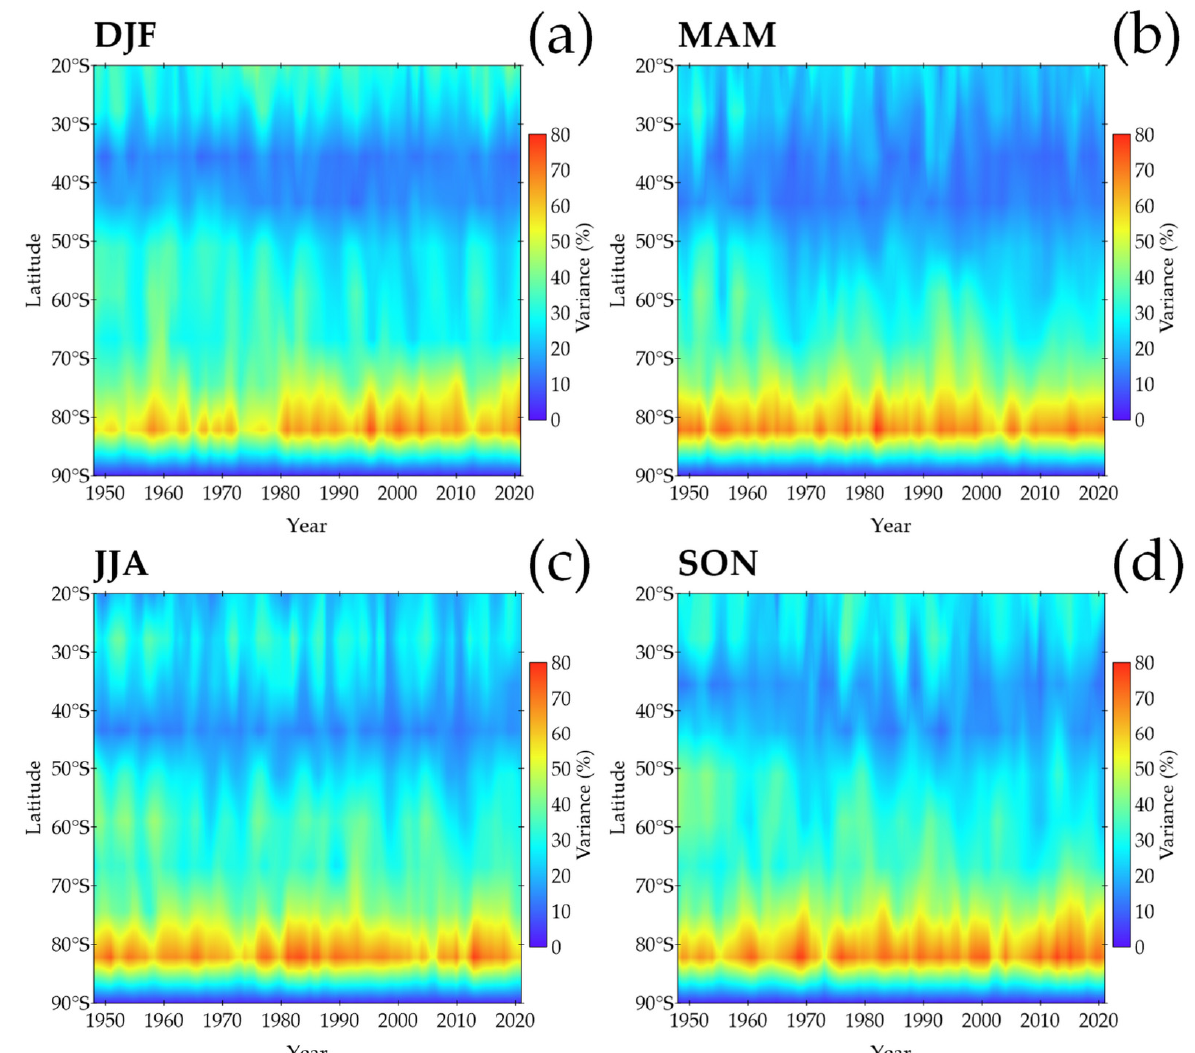
Figure 2. Contribution of wave 1 in Equation (1) to the total variance of the 500 hPa geopotential height across the 74-year period in terms of seasonal means: ( a ) DJF; ( b ) MAM; ( c ) JJA; ( d ) SON.